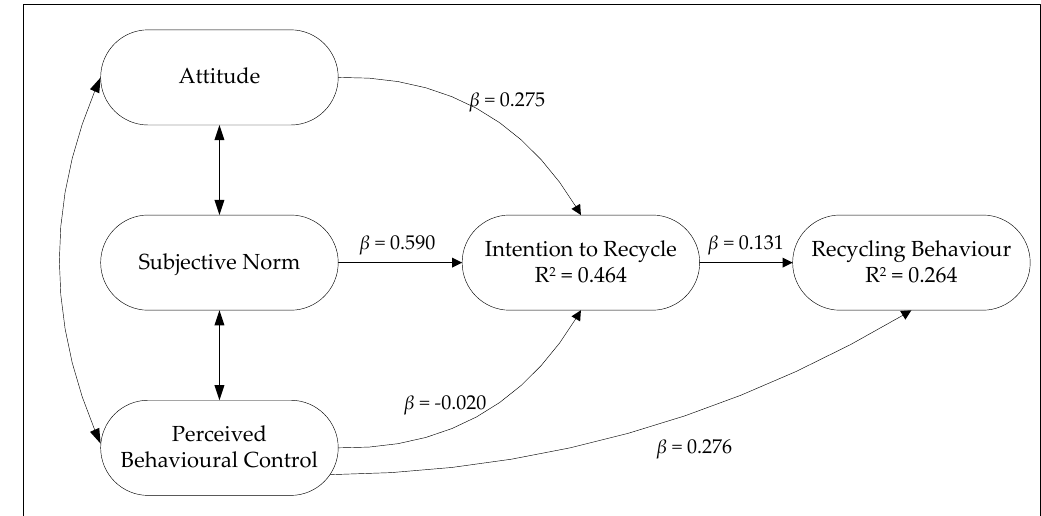
Figure 3. Path diagram of the TPB fitted to the unstandardized/raw latent variables.